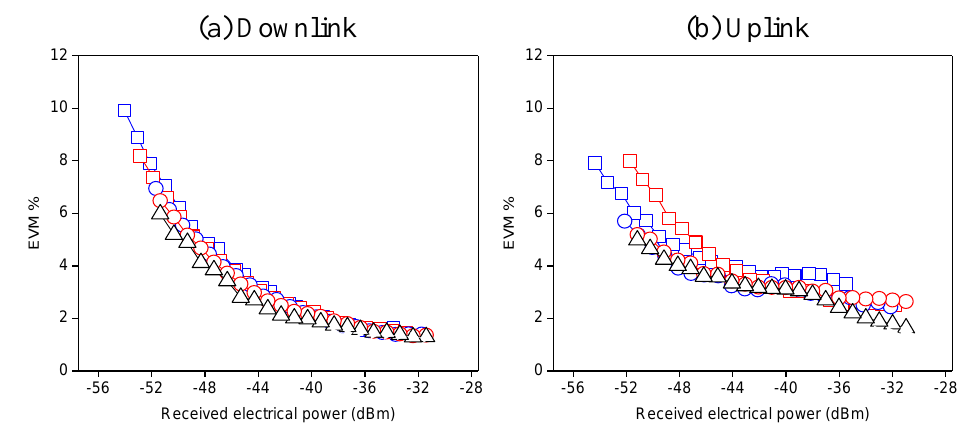
Figure 4. EVM vs. received electrical power for fixed channels. F 2 ( 